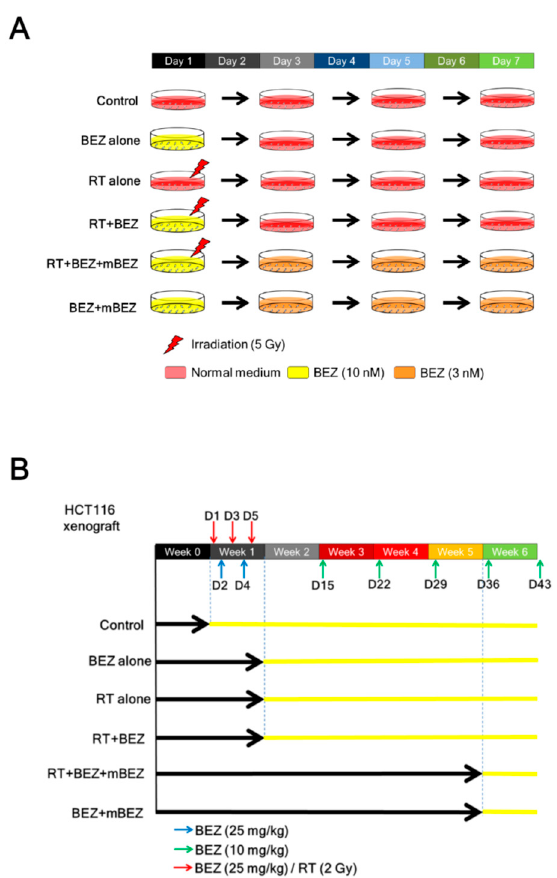
Figure 1. Schematic diagram of the therapeutic protocol. ( A ) In vitro experiments. CRC cells were separated into six groups: control group (untreated), NVP-BEZ235 alone group (BEZ alone), radiotherapy (RT) alone group (RT alone), RT + BEZ235 group (RT + BEZ), RT + BEZ235 + maintenance BEZ235 group (RT + BEZ + mBEZ), and BEZ235 + maintenance BEZ235 (BEZ + mBEZ). ( B ) In vivo experiments. Immunocompromised mice were subcutaneously injected with 1 × 10 6 HCT116 cancer cells and then divided into six groups.